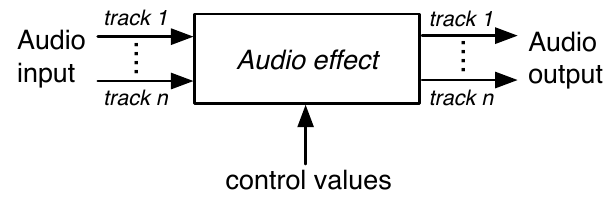
Figure 1. An audio effect and its